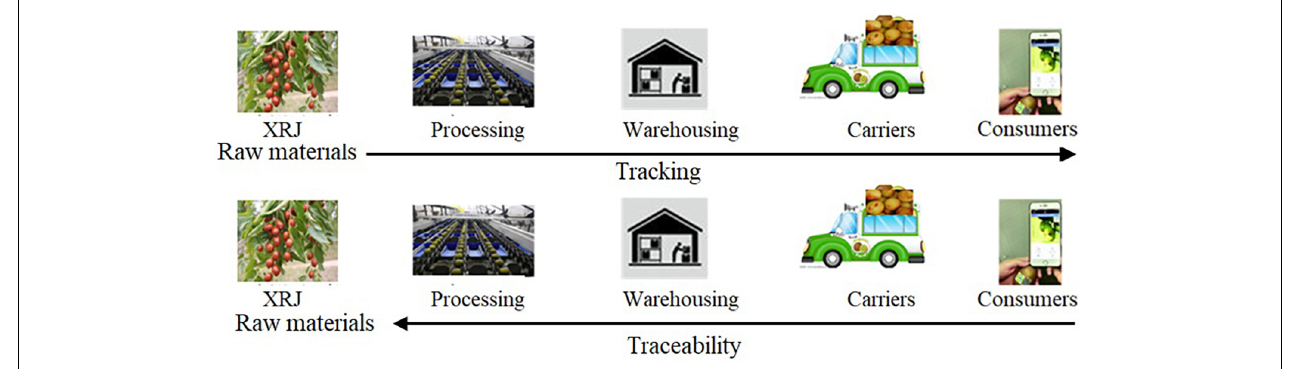
FIGURE 1 | Tracking and traceability system of Xinzheng red jujube (XRJ).